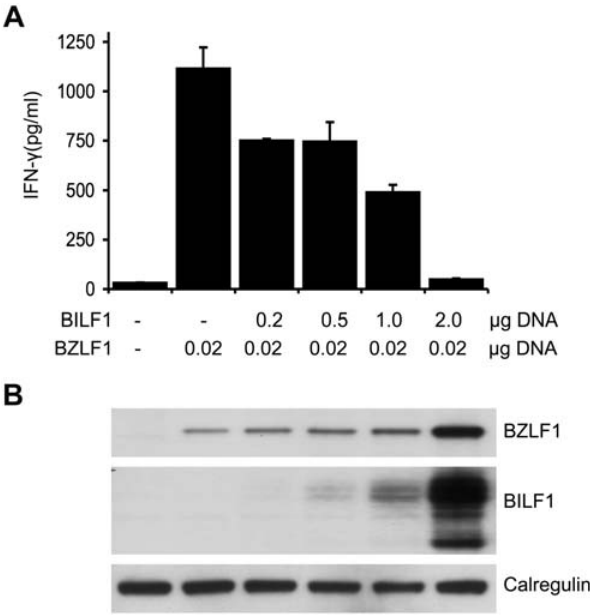
Figure 3. BILF1 inhibits T cell recognition of endogenous EBV antigen in MJS cells. ( A ) MJS cells were co-transfected with 0.02 m g p509 plasmid (BZLF1 expression vector) and different amounts (0–2 m g) of pCDNA3-HABILF1-IRES-nlsGFP bulked to a constant amount of DNA with control plasmid. At 24 hr post-transfection, the MJS cells were co- cultured with CD8 + effector ‘RAK’ T cells for a further 18 hrs and the supernatants were tested for the release of IFN- c as a measure of T cell recognition. All results are expressed as IFN- c release in pg/ml and error bars indicate standard deviation of triplicate cultures. ( B ) Total cell lysates were generated from the above transfections, and 2 6 10 5 cell equivalents were separated and analyzed by Western Blotting using antibodies specific for BZLF1, HA tag (BILF1), or calregulin as a loading control.